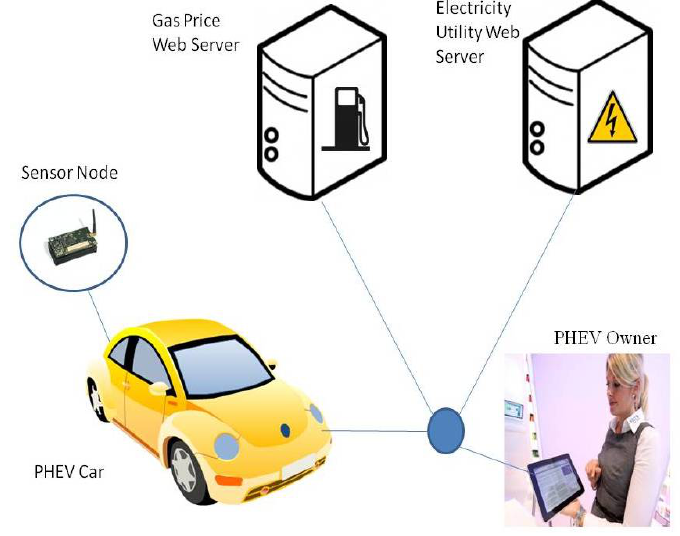
Figure 3. Management of PHEV charging model from the smart grid using sensor web